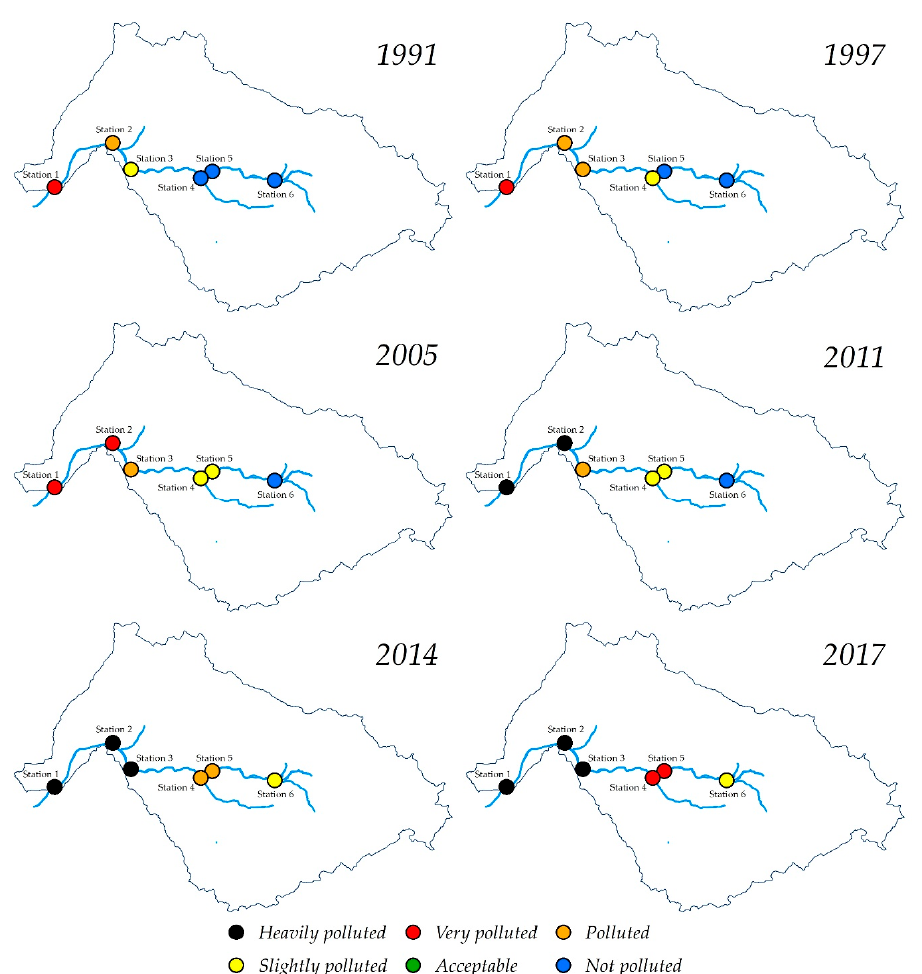
Figure 7. Water quality according to Prati’s Implicit Index of Pollution (IPI) at measuring stations 1–6, including their corresponding upstream sampling sites, in 1991, 1997, 2005, 2011, 2014, and 2017. Table 8. Values of Mann–Kendall’s tau and Theil–Sen slope obtained for the National Sanitation Foundation-Water Quality Index (NSF-WQI) and Prati’s Implicit Index of Pollution (IPI) at measuring stations 1–6,